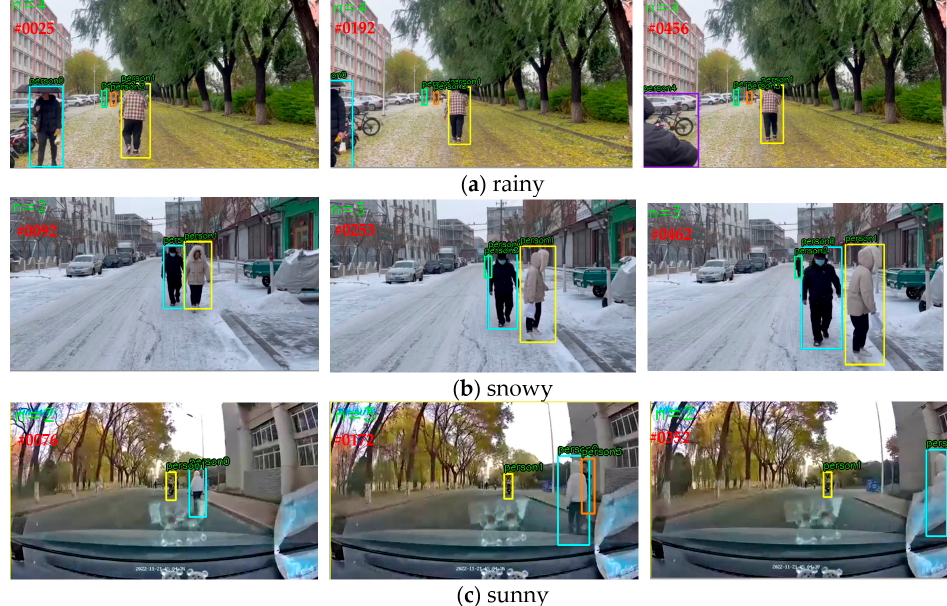
Figure 9. The tracking results of di ff erent real driving data for the testing